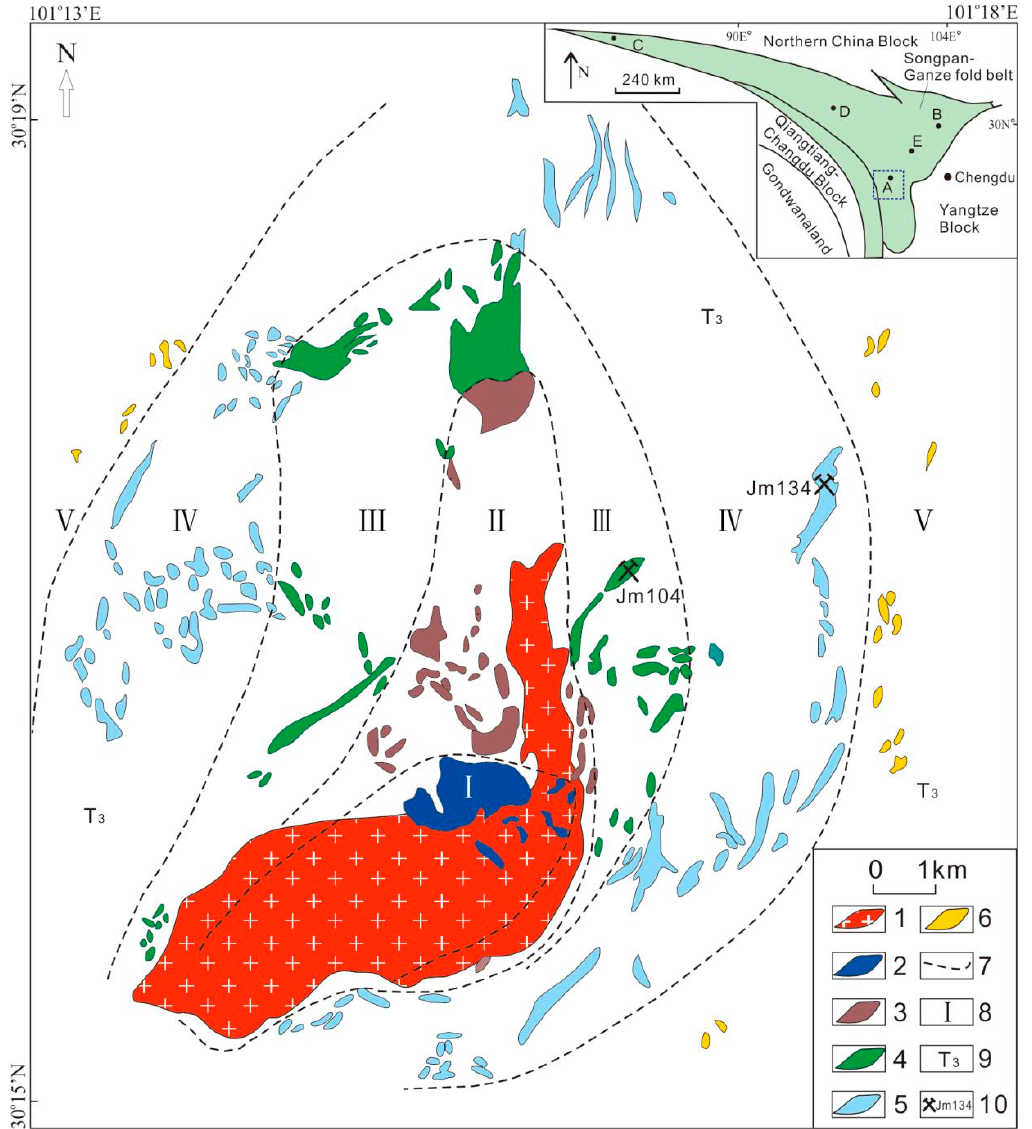
Figure 2. Distribution map of granitic pegmatites in the Jiajika Li–Be–Nb–Ta deposit, Sichuan Province, China. 1: Two-mica granite; 2: Microcline pegmatite; 3: Microcline–albite pegmatite; 4: Albite pegmatite; 5: Albite–spodumene pegmatite; 6: Lepidolite (muscovite) pegmatite; 7: Zoning lines of different types of pegmatite; 8: Zone number of different pegmatite types. I: Microcline pegmatite zone; II: Microcline–albite pegmatite zone; III: Albite pegmatite zone; IV: Spodumene pegmatite zone; V: Lepidolite (muscovite) pegmatite zone; 9: Upper Triassic sandstone and mudstone; 10: Muscovite sampling location with sample number in Table 1. The legend for the diagram in the upper right-hand corner is provided in Figure 1.